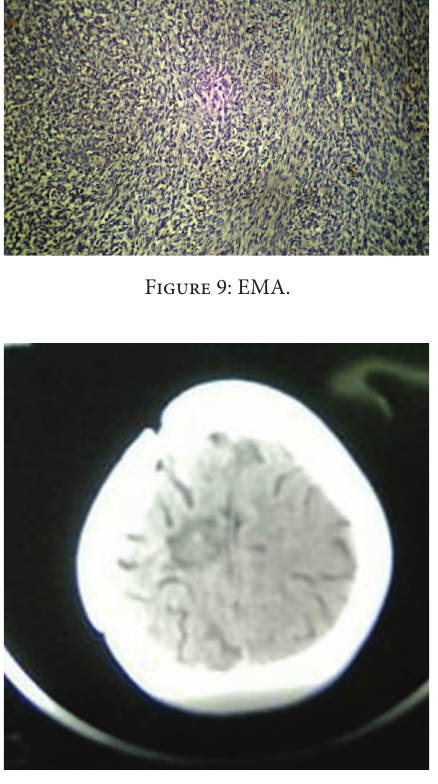
Figure 10: Post-op CT scan brain with residual